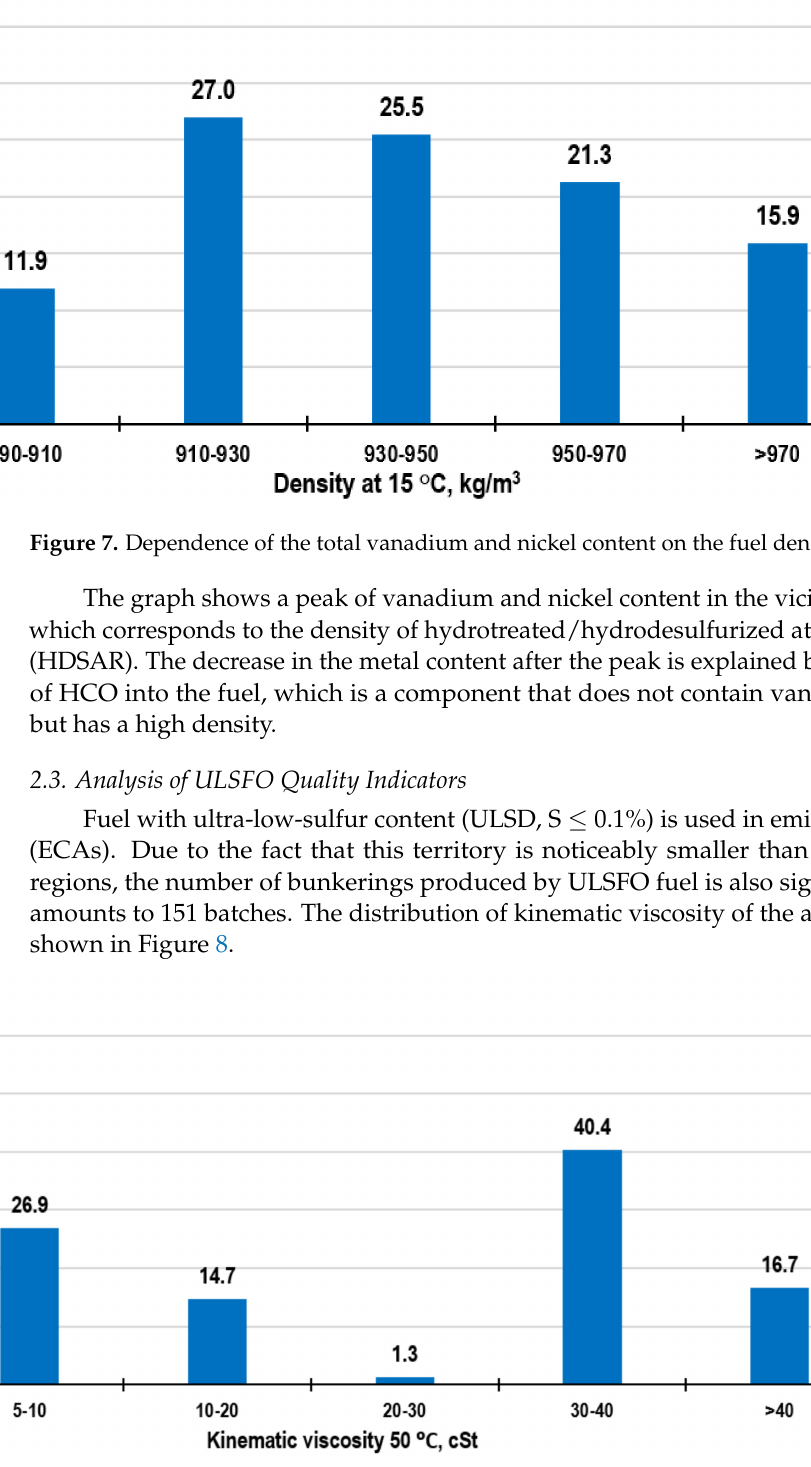
Figure 8. Kinematic viscosity of ULSFO bunkered in the world ports